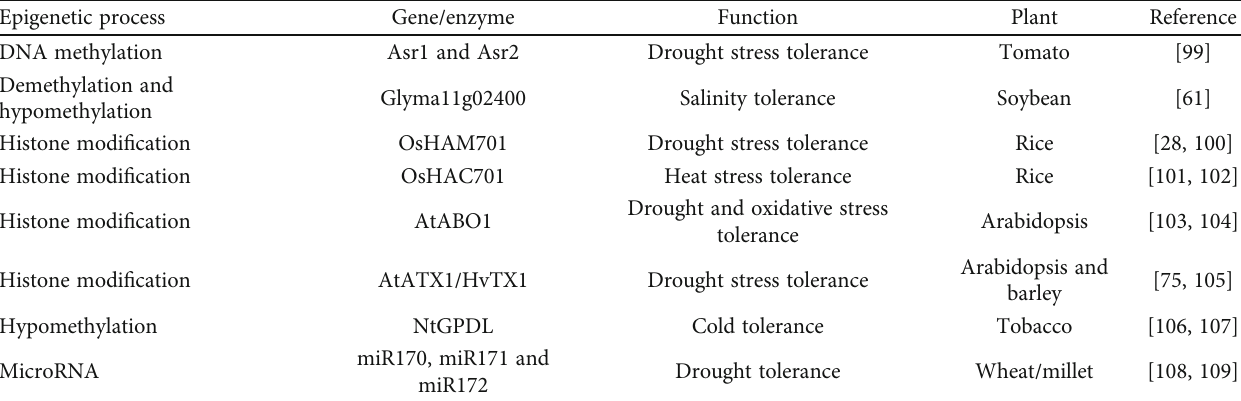
Table 1: Di ff erent epigenetic processes and the associated genes.